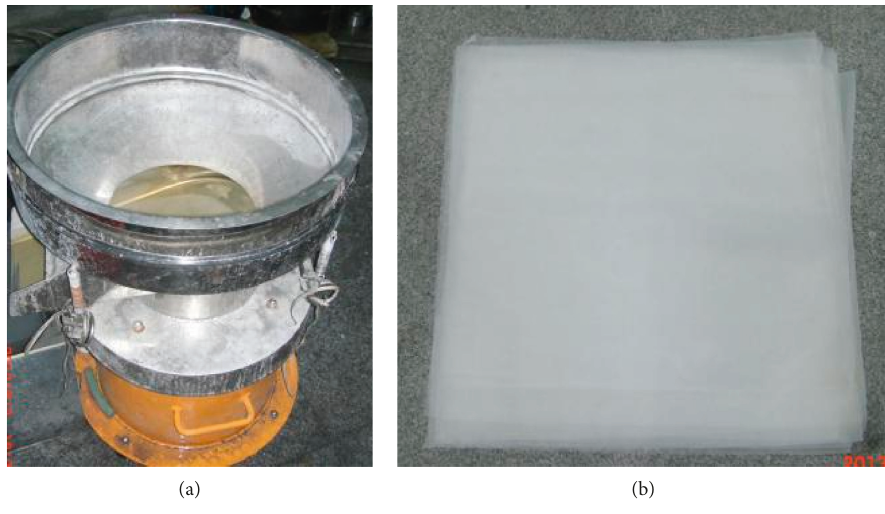
Figure 6: The (a) vibrosieve and (b) filter